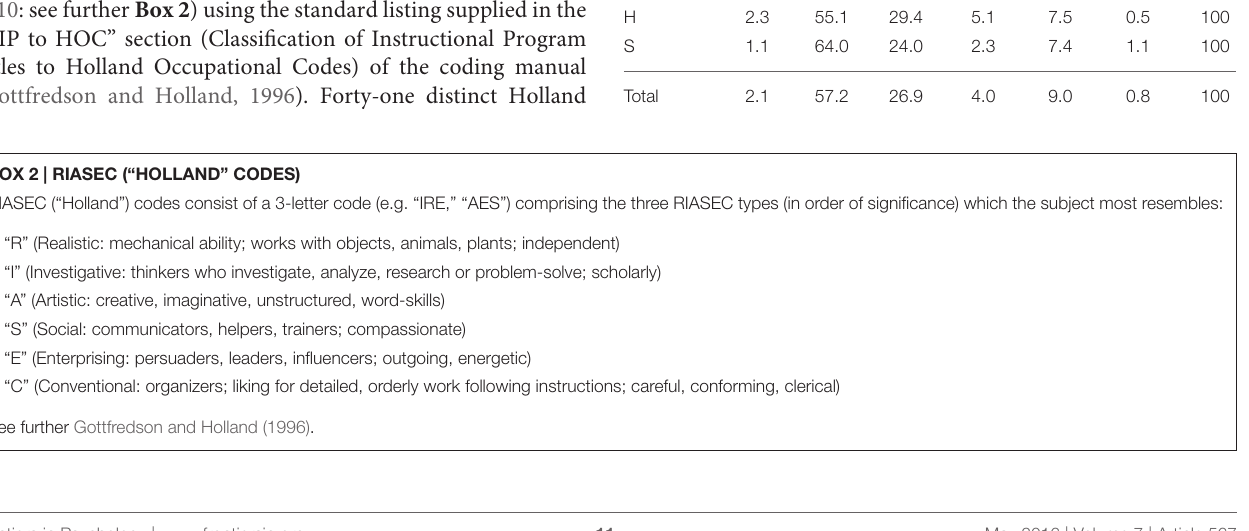
TABLE 4 | RIASEC analysis (primary code) of main educational field by expertise group. Expertise